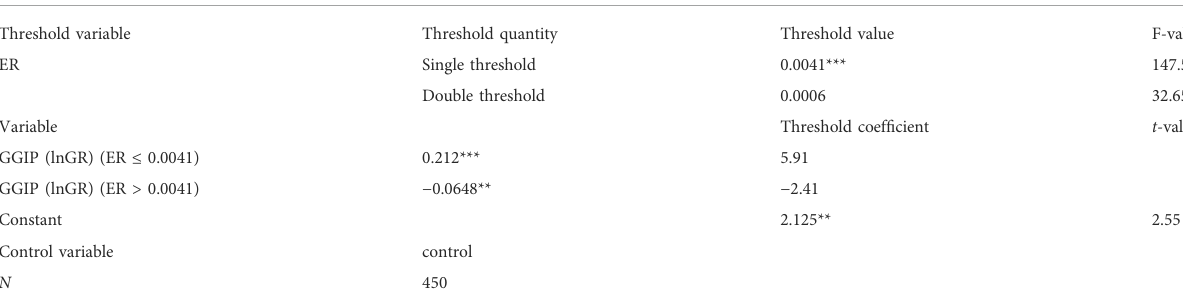
TABLE 5 Threshold